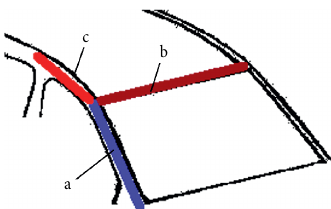
Fig. 4. Simplified structure of the tested vehicle (Schmitt 2009)